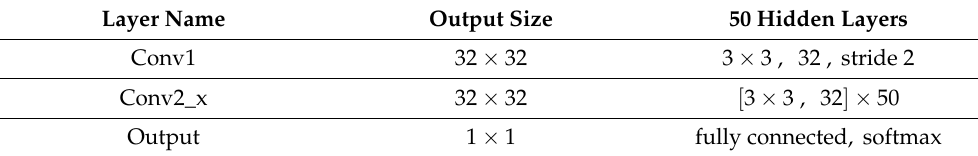
Figure 4. CNN block diagram for 50 convolutional hidden layers. Table 1. Detailed architecture of 50 convolutional layer baseline (Plain-50).